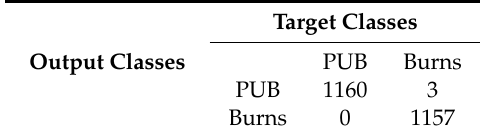
Table 1. Support Vector Machine (SVM) classification using ResNet50 features.